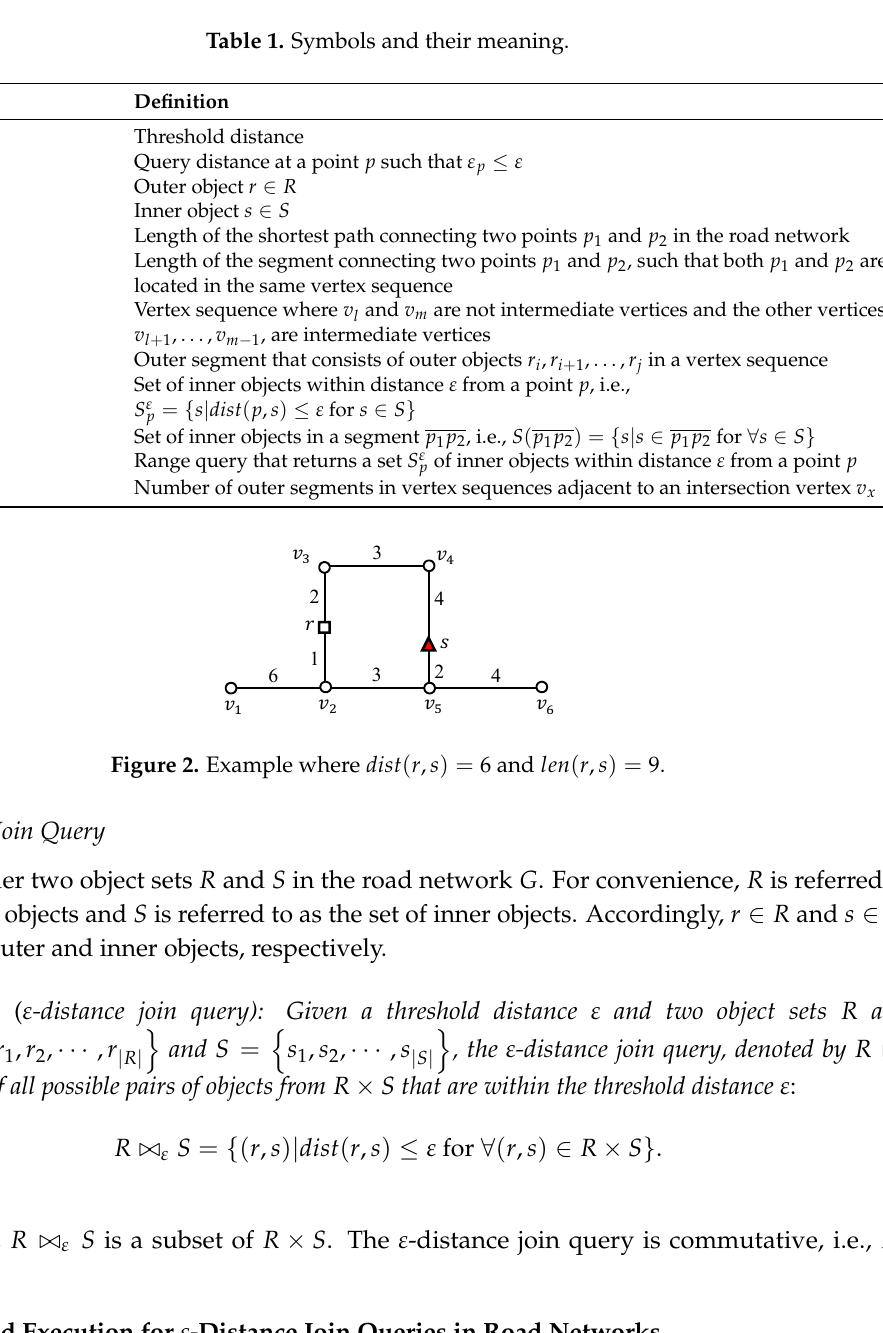
Figure 3. Example of an (cid:2013) -distance join query in a road network.